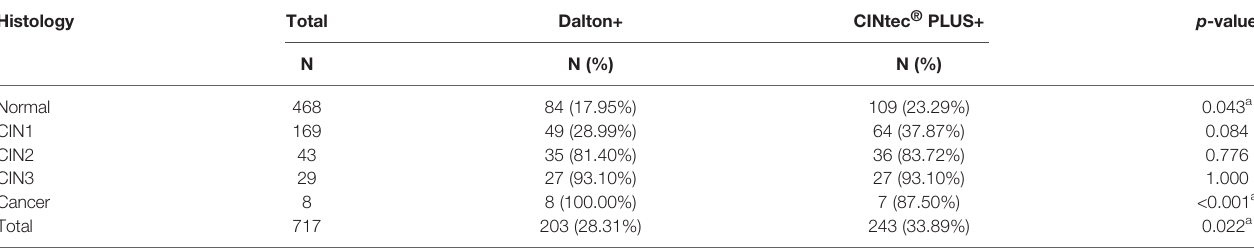
TABLE 1 | The positivity of Dalton and CINtec ® PLUS p16/Ki-67 Dual Stain in different histopathology groups. Histology Total Dalton+ CINtec ® PLUS+